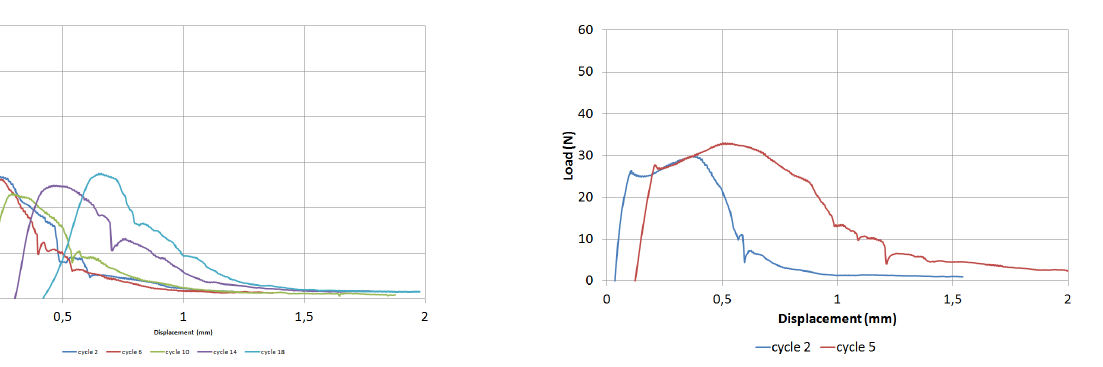
Table 3: Yellow instrument test results.